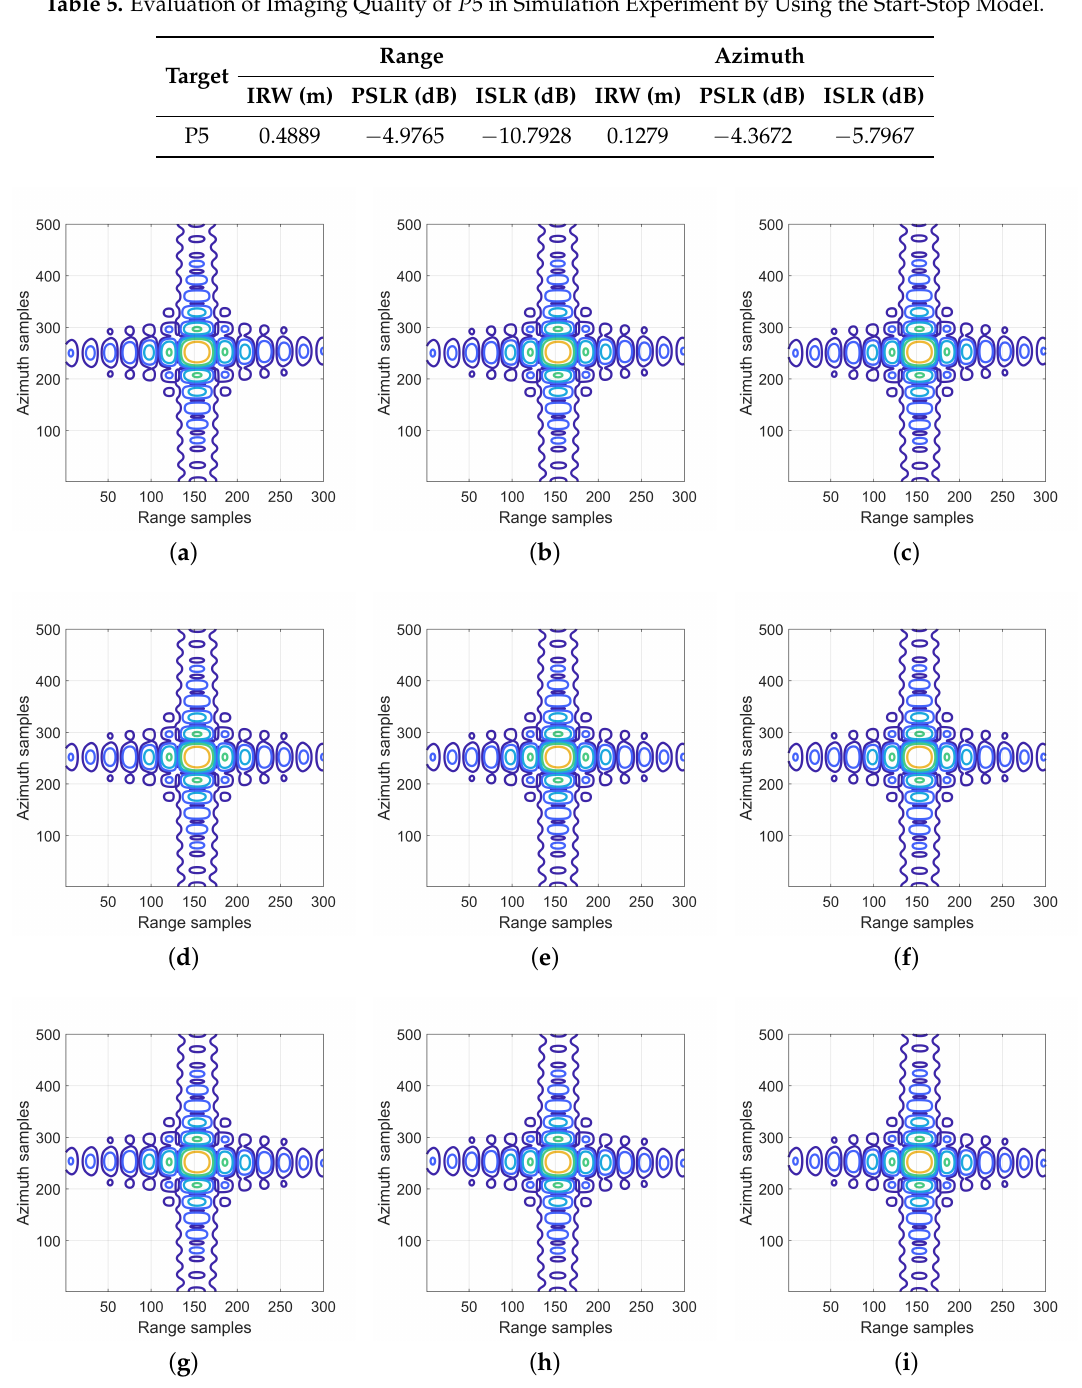
Table 5. Evaluation of Imaging Quality of P 5 in Simulation Experiment by Using the Start-Stop Model.